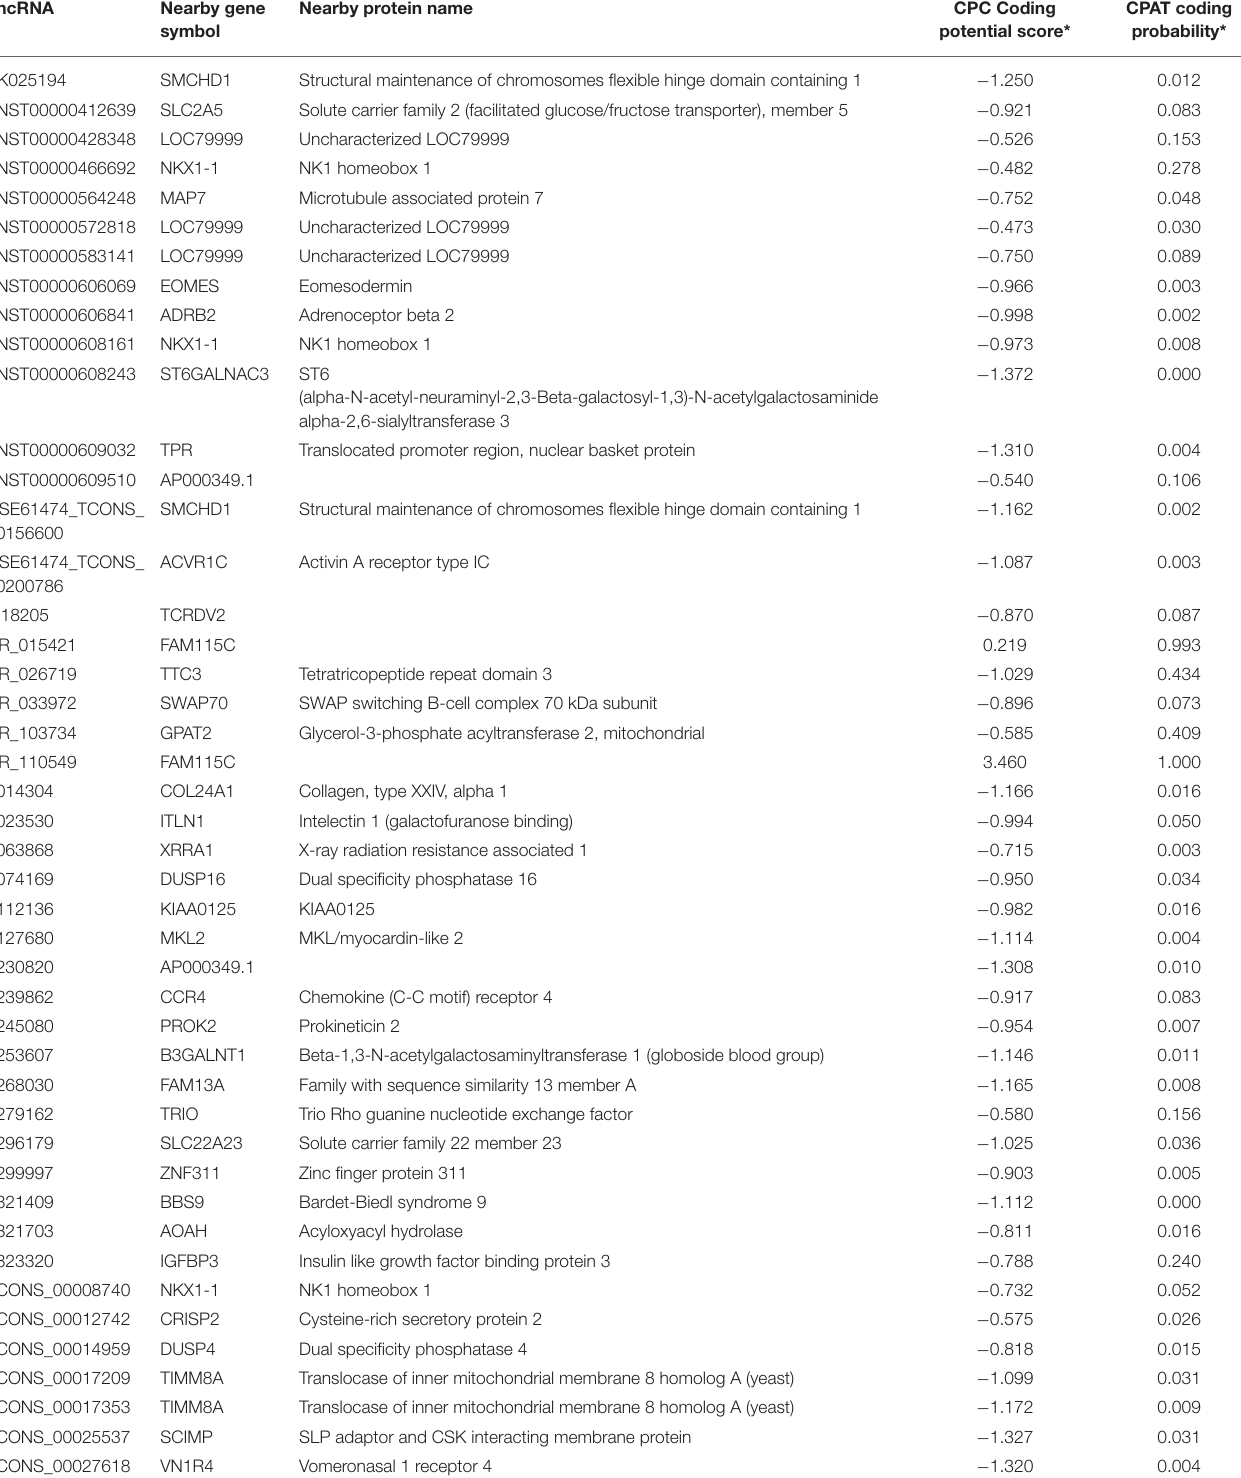
TABLE 3 | Sixty-two differentially expressed lncRNAs were selected for validation of their coding potential using two prediction software programs, CPAT and CPC. LncRNA Nearby gene